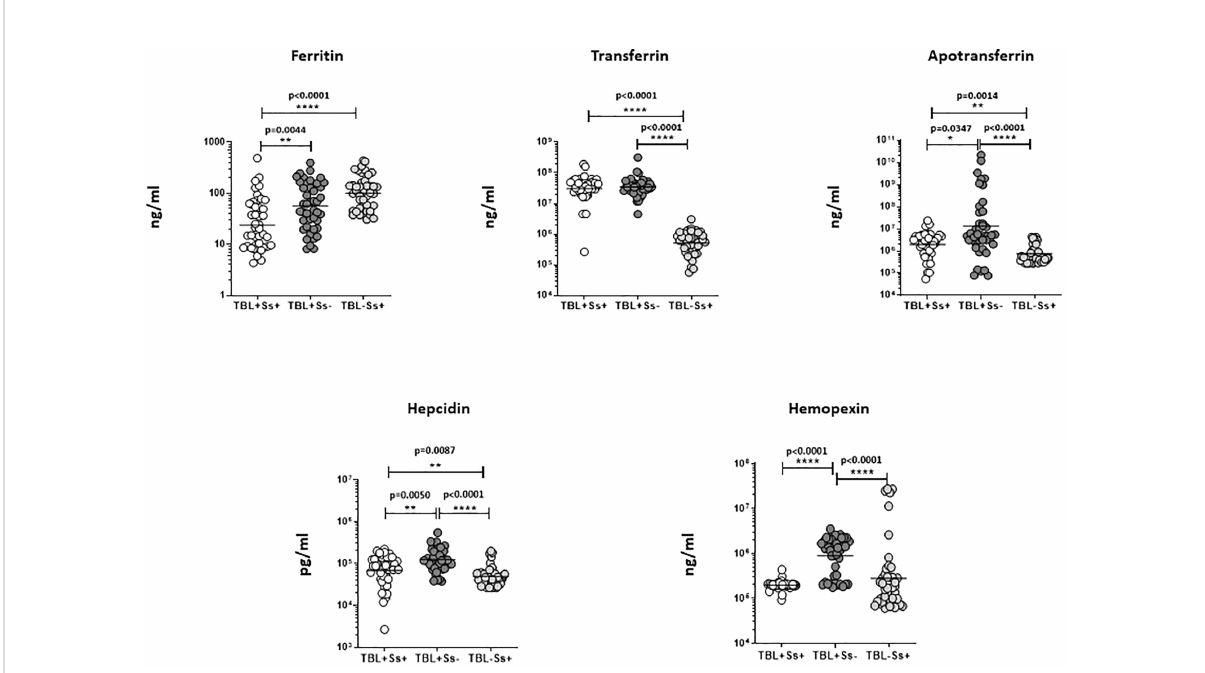
FIGURE 2 Iron status biomarker plasma levels in TBL+ (Ss+, Ss-) and TBL-Ss+ groups. We have measured the iron status (ferritin, transferrin [TF], apotransferrin [ApoT], hepcidin, hemopexin) biomarker systemic levels in TBL+ (Ss+, n=44), (Ss-, n=44) and TBL-Ss+ (n=44) groups by ELISA. We showed the fi gures using scatter plots with an individual circle denoting a single participant. We used Kruskal-Wallis Dunn ’ s multiple comparisons test to measure the statistical P values. The signi fi cance of p values was represented as '*' p<0.05, '**' p<0.01, '****'